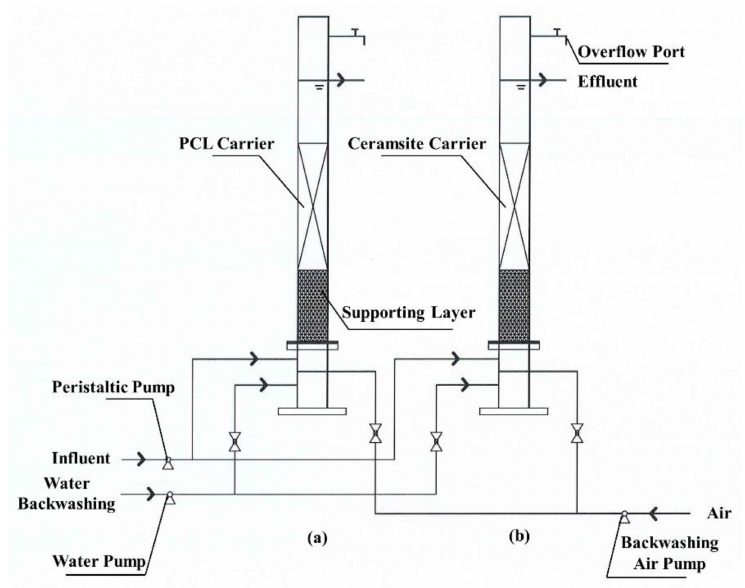
Figure 1. Device scheme: ( a ) Reactor 1; and ( b ) Reactor